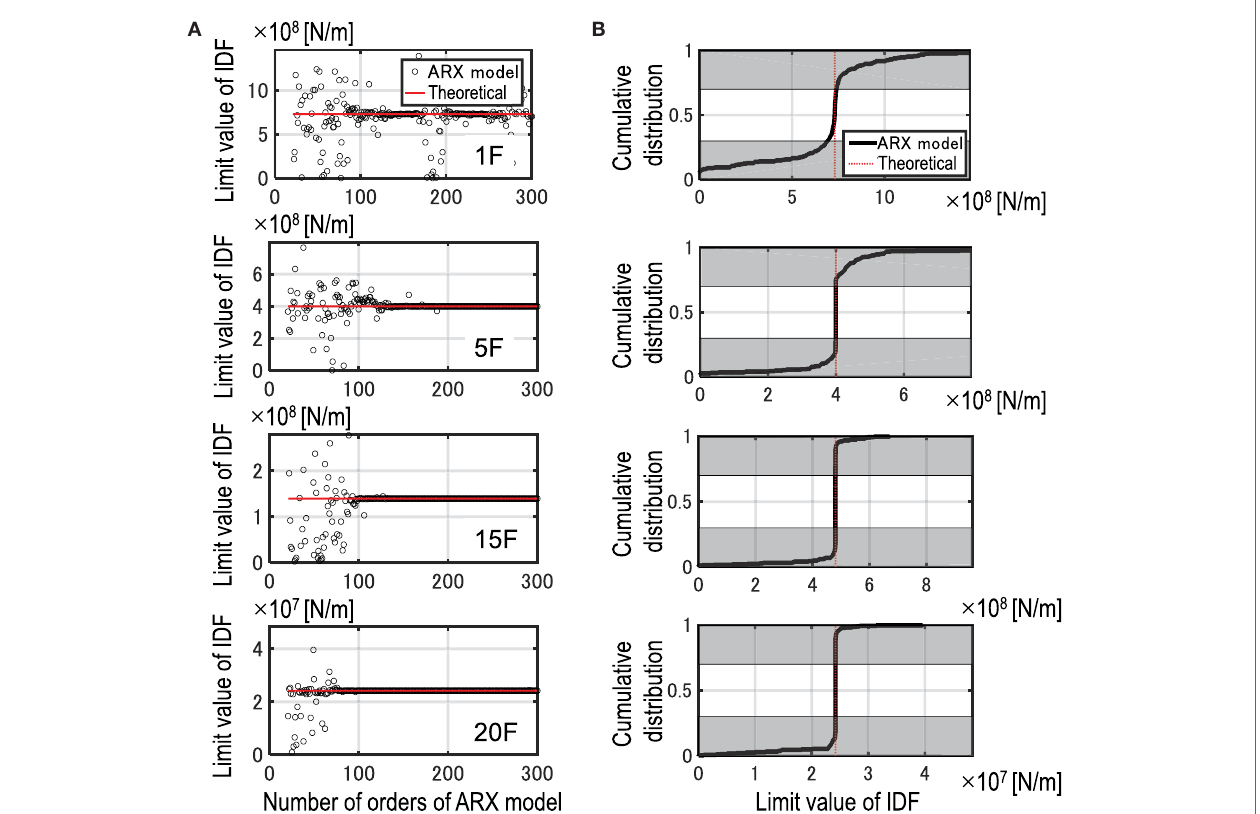
FIGURE 4 | Limit value evaluation of identification function without selection of number of orders of ARX model: (A) variation of limit value of IDF and (B) cumulative distribution of limit value of IDF .